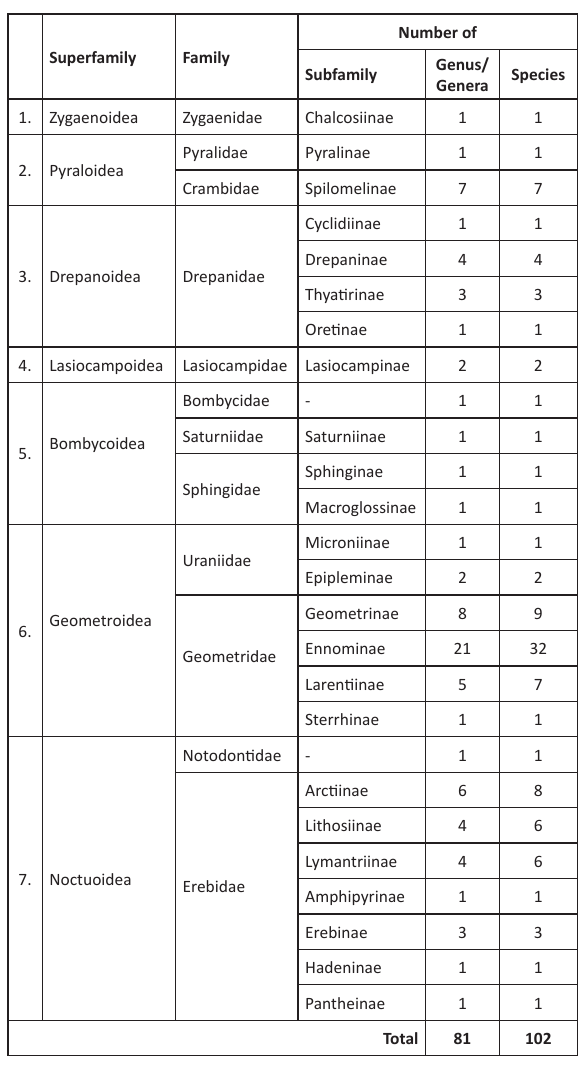
Table 2. The diversity of moths in Tawang District, Arunachal Pradesh, India as recorded in the present